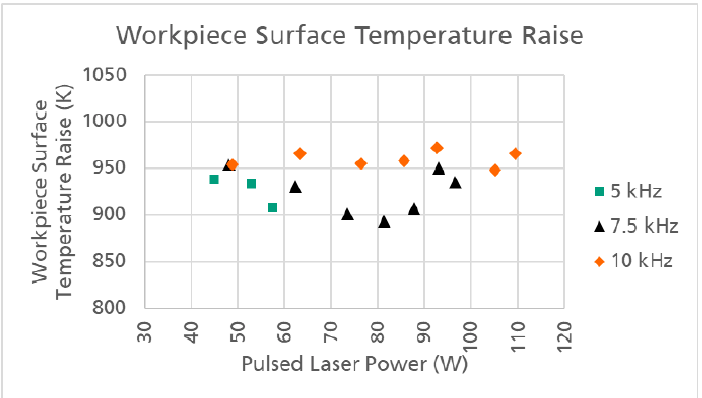
Figure 6. Surface temperature raise during LMD-w of QuFe13 wire on S355 substrates with the dual beam process. 2500 W cw, 1000 mm/min machine feed rate and 1800 mm/min wire feed rate with back feeding and different pulsed laser parameter sets.